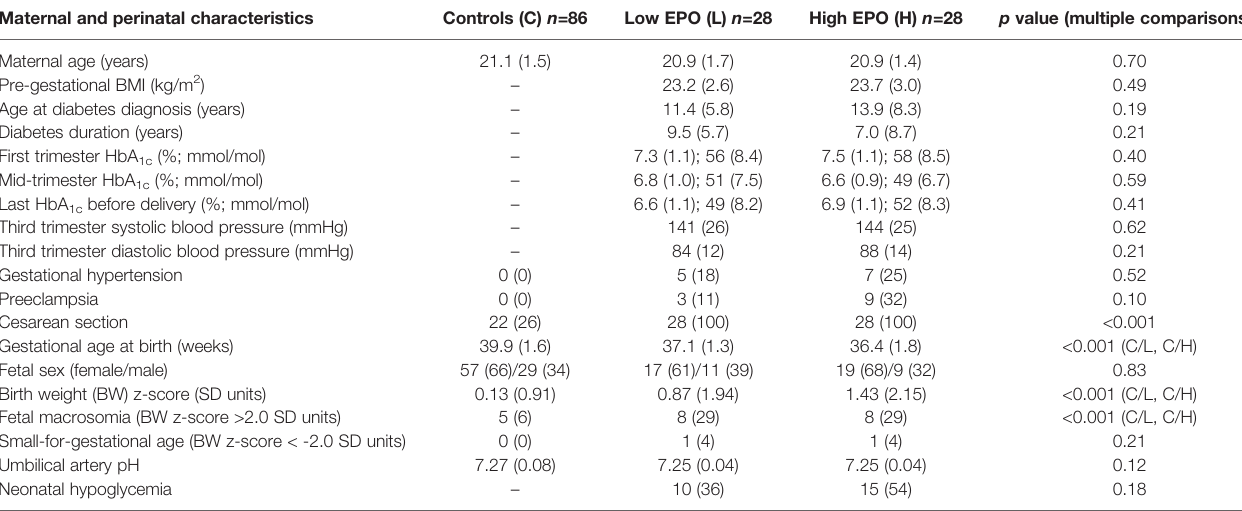
TABLE 1 | Maternal and perinatal characteristics of mother-offspring pairs affected by maternal type 1 diabetes and matched control (C) offspring. Maternal and perinatal characteristics